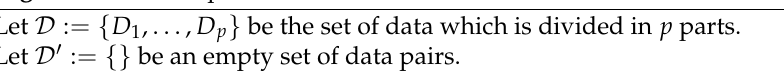
Algorithm 1 Data Split